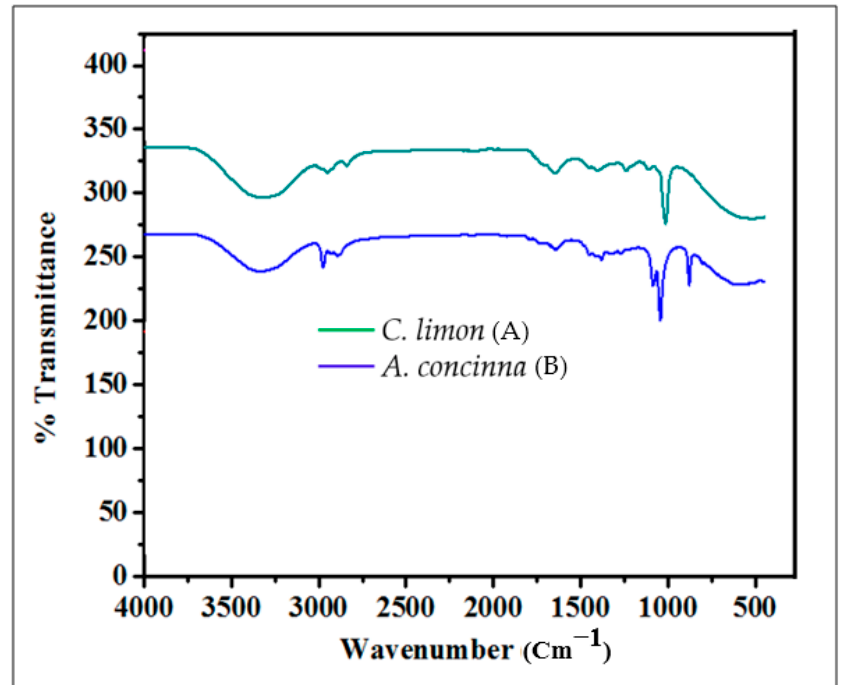
Figure 1. FTIR analysis of phytochemicals in the plant extracts. ( A ) FTIR trace of Citrus limon ; ( B ) FTIR trace of Acacia concinna.